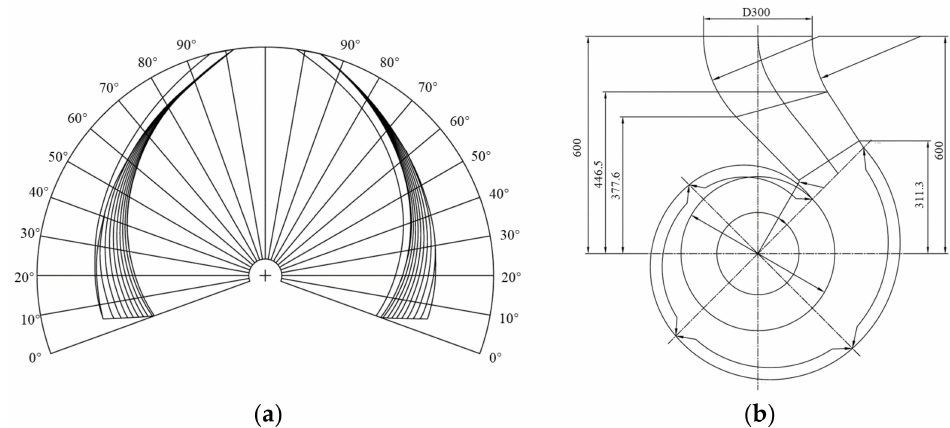
Figure 1. Impeller and volute hydraulic model diagram: ( a ) impeller; ( b ) volute.